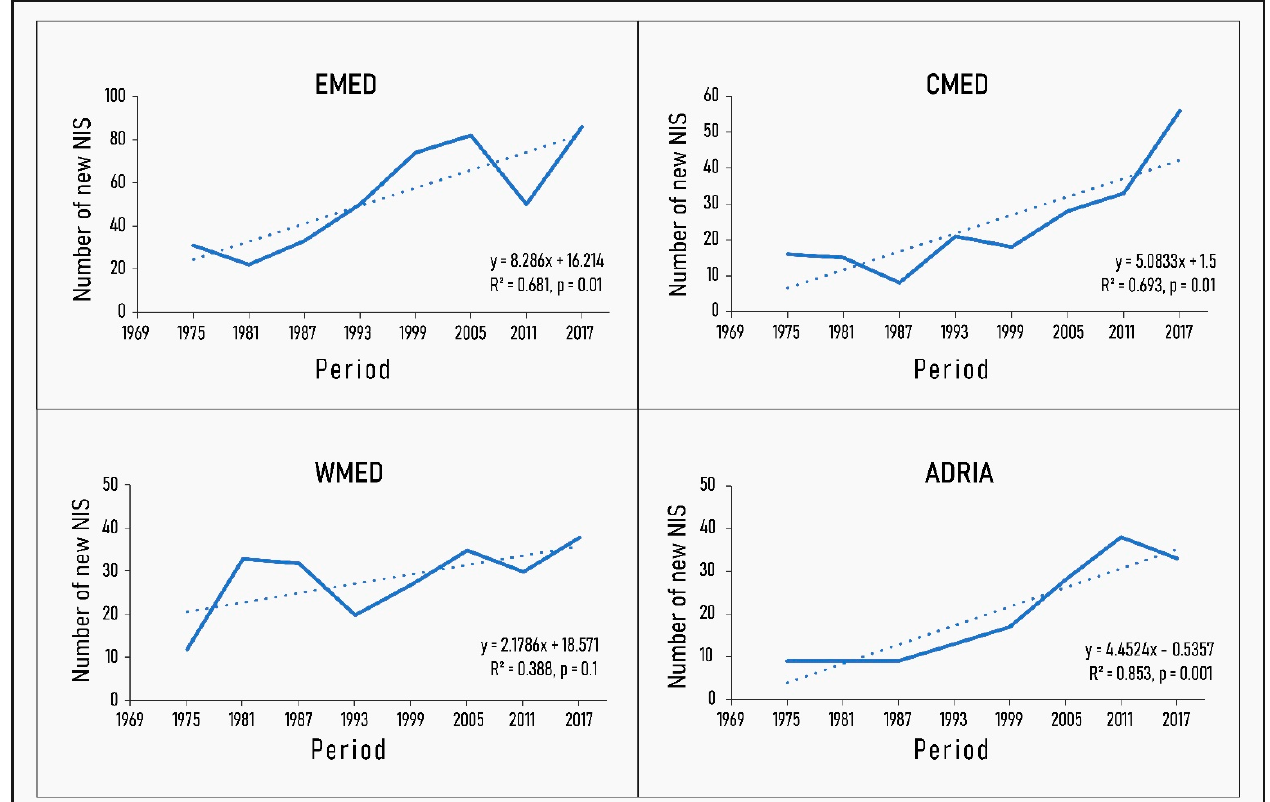
Figure 1. Trends in non-indigenous species (NIS) introductions per six-year cycle at the Marine Strategy Framework Directive (MSFD) subregion level with fitted linear regression lines superimposed. The R 2 and p-values of the linear fit are also given.